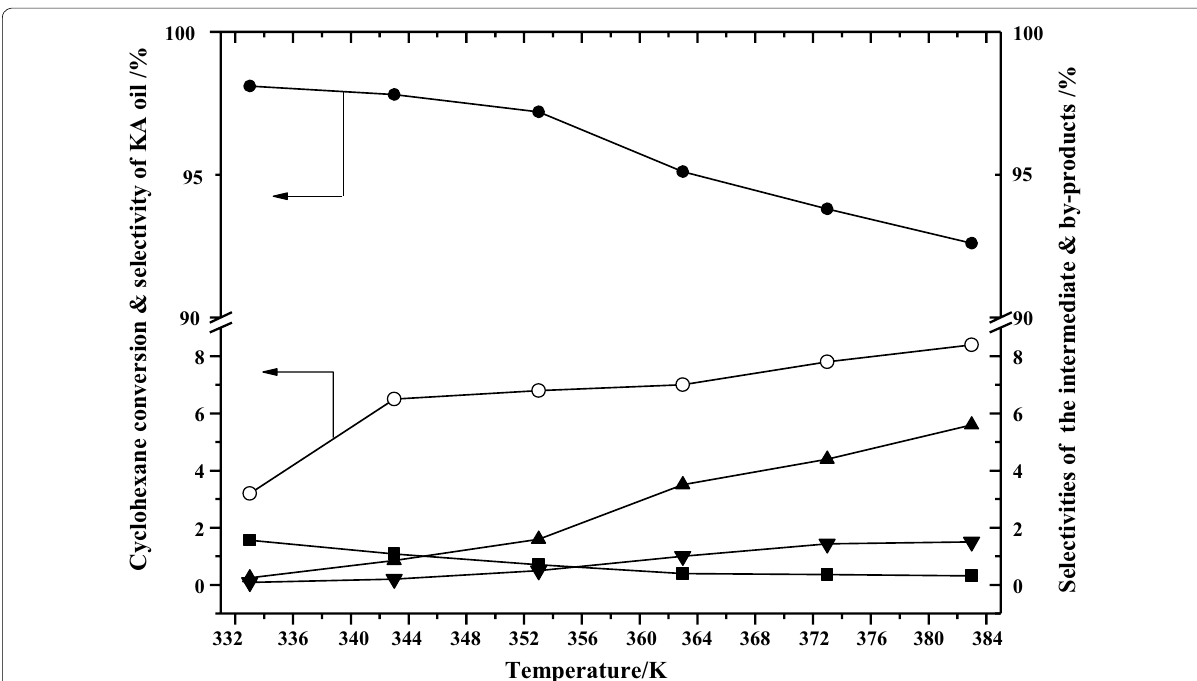
Fig. 5 Effect of reaction temperature on cyclohexane conversion, selectivities for the main product, intermediate product, and by-products. Reac- tion conditions: cyclohexane 100 mL, VAlPO 4 berlinite catalyst 5 mg, acetic acid solvent 40 mL, O 2 pressure 0.1 MPa, reaction time: 4 h. (White circle) cyclohexane conversion; (Black circle), (Black square), (Black up-pointing triangle) and (Black down-pointing triangle) selectivity for KA oil, CHHP, acids and esters, respectively. KA oil: cyclohexanol and cyclohexanone; CHHP: cyclohexyl hydroperoxide; acids: C 4 –C 6 diacids; esters: synthesized by the reaction of